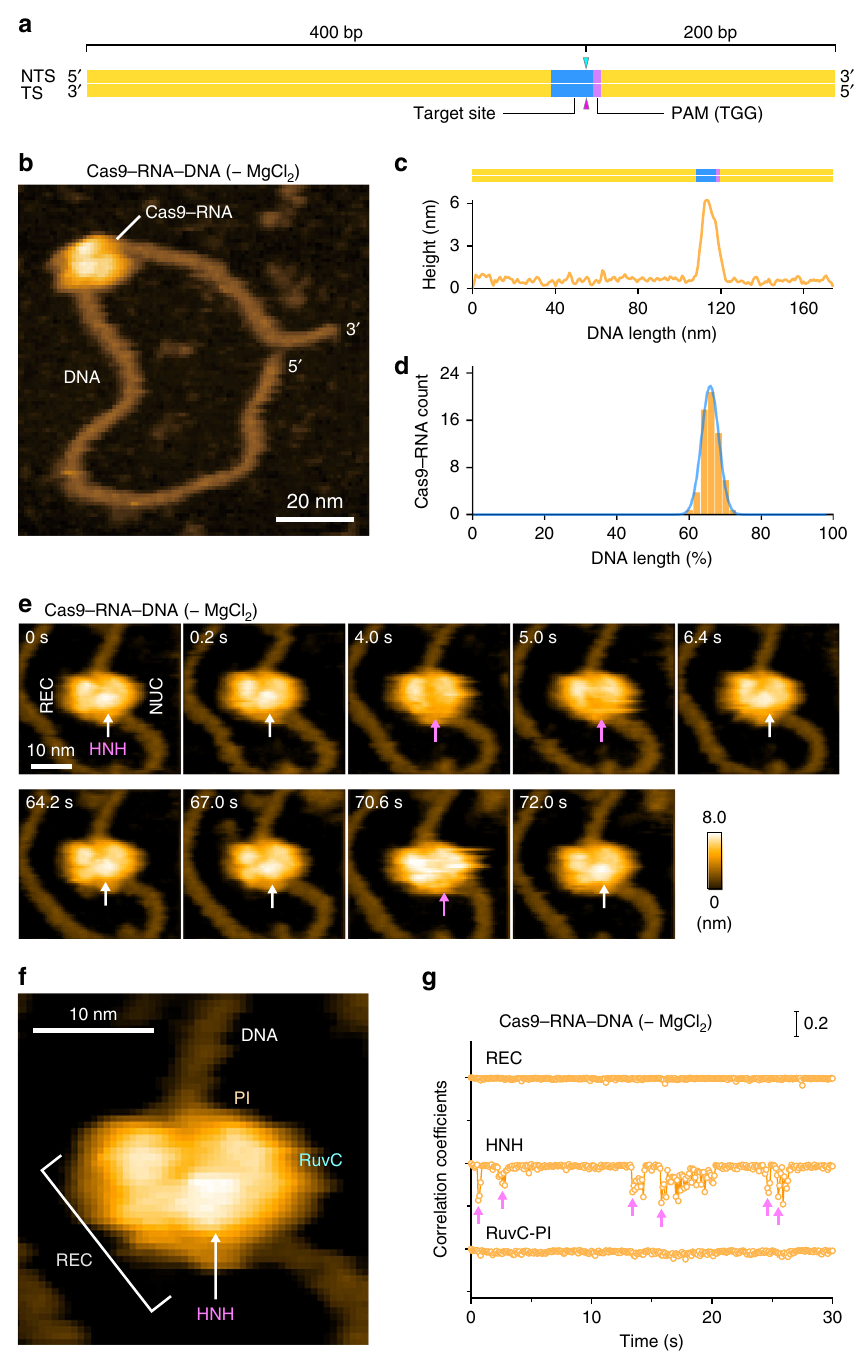
Fig. 2 HS-AFM observations of Cas9 – RNA – DNA. a Schematic of the dsDNA substrate. The target site and the PAM are colored blue and purple, respectively. The sites cleaved by the RuvC and HNH domains are indicated by the cyan and magenta triangles, respectively. TS, target strand; NTS, non-target strand. b HS-AFM image of Cas9 – RNA – DNA in the absence of MgCl 2 . The scale bar is 20 nm. c Cross-sectional pro fi le along the DNA in a representative HS-AFM image of Cas9 – RNA – DNA. d Distribution of the height peaks in the HS-AFM images of Cas9 – RNA – DNA ( n = 65). The peak distribution fi ts a Gaussian curve, with the peak corresponding to the target site. e Sequential HS-AFM images of Cas9 – RNA – DNA in the absence of MgCl 2 . The HNH domain is indicated by white arrows, whereas its disappearance ( fl uctuation) is indicated by magenta arrows. The scale bar is 10 nm. f Close-up view of a representative HS-AFM image of Cas9 – RNA – DNA. The scale bar is 10 nm. g Time courses of correlation coef fi cients for the individual domains between the sequential HS-AFM images of Cas9 – RNA – DNA in the absence of MgCl 2 . The HNH domain fl uctuations are indicated by magenta